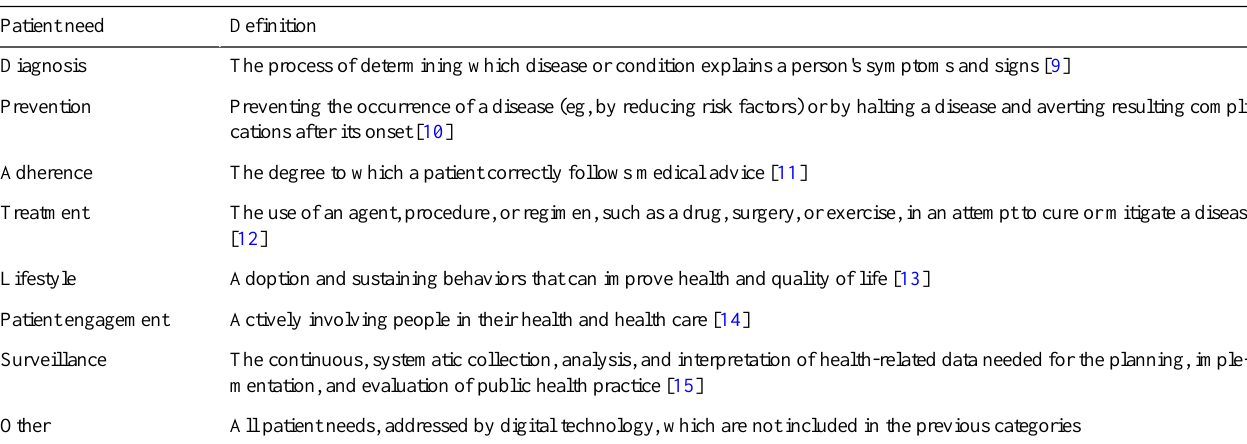
Table 1. Definitions of the patient needs addressed by digital